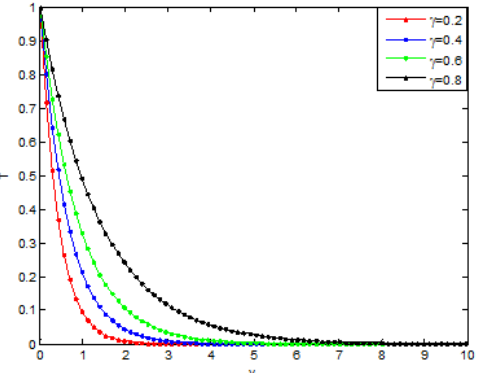
Figure 4. Effects of Casson parameter on temperature profile of the Casson nanofluid